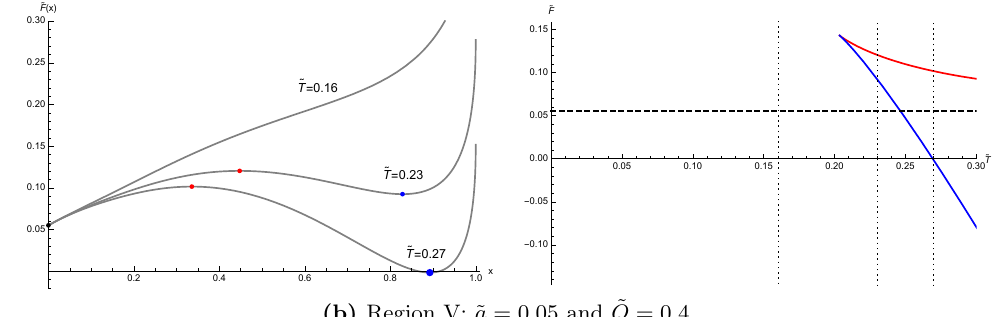
Figure 5. Plots of the free energies ~ F ( x ) and ~ F against ~ T for the BI BHs in Regions IV and V, which are Schwarzschild-like type. The blue/green branches are Large/Small BH, and the brown/red branches are Intermediate BH. The horizontal black dashed line is ~ F (0). As ~ T increases from zero, there is always a single (cid:12)rst-order phase transition from the edge state to Large BH occurring at some